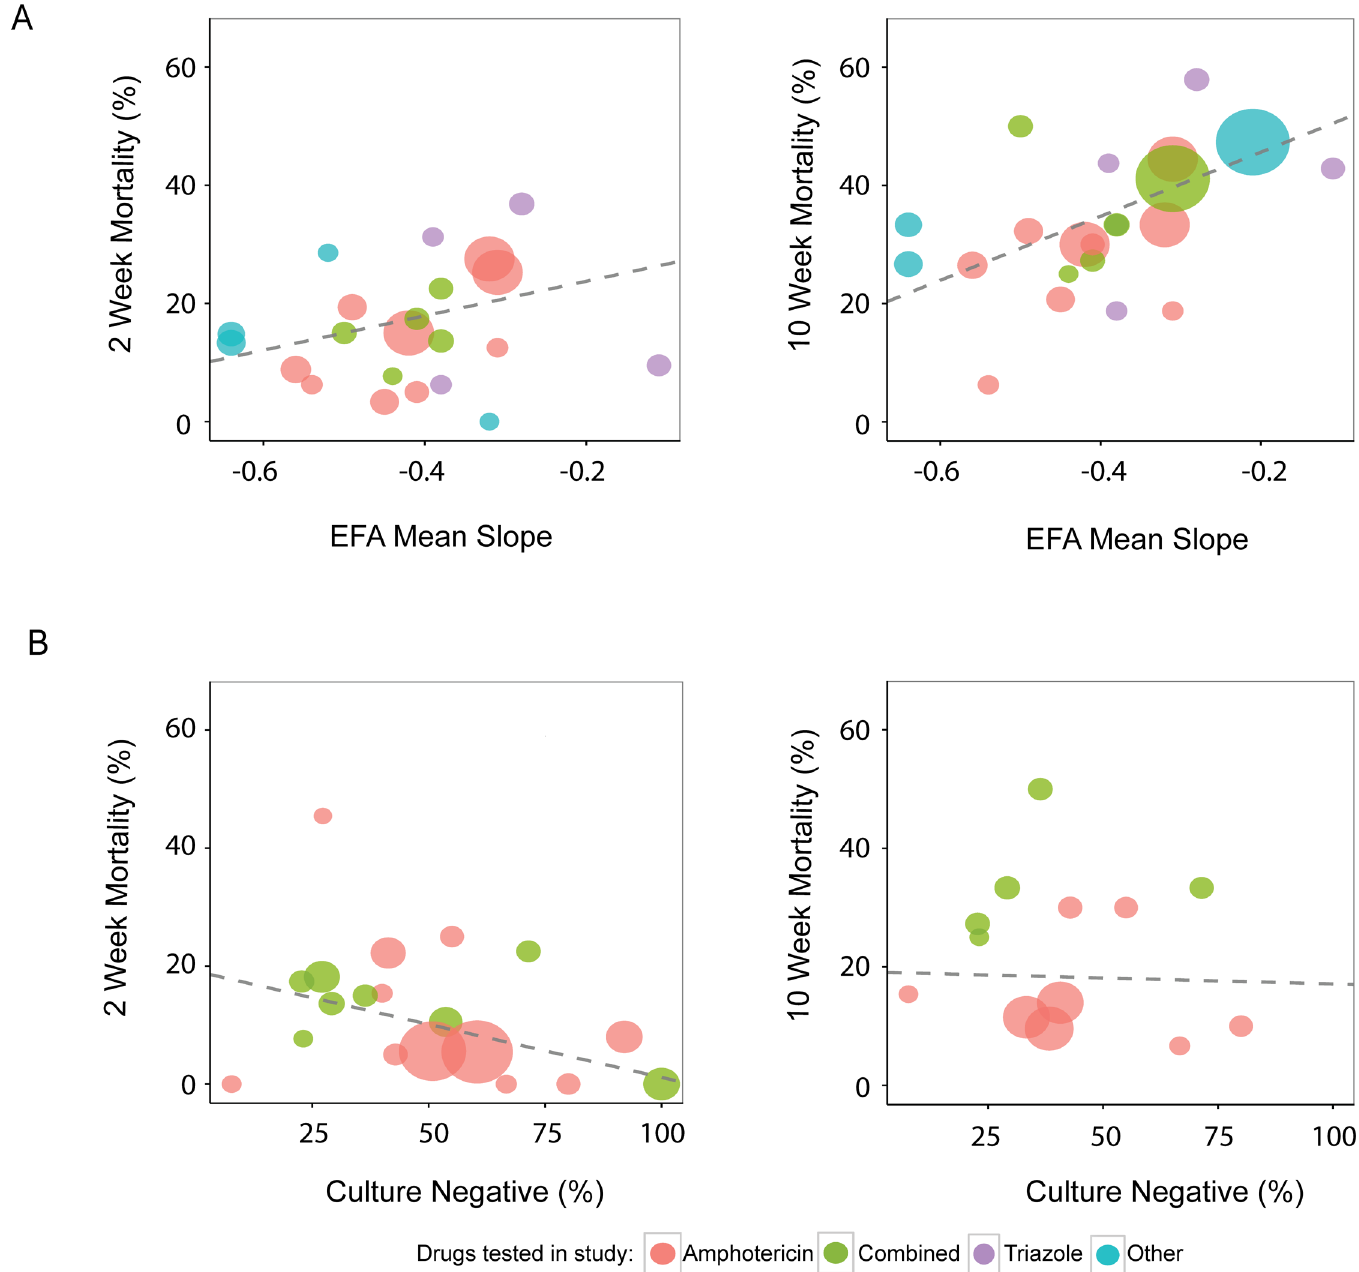
Fig 3. Group-level correlation of EFA and ACM regardless of treatment, all studies. All studies with non-missing data are displayed. N = 16 studies and 40 arms A) Mean EFA slope vs ACM at 2 and 10 weeks (9 studies and 24 arms). B) % CSF culture negative vs. ACM at 2 and 10 weeks (9 studies and 22